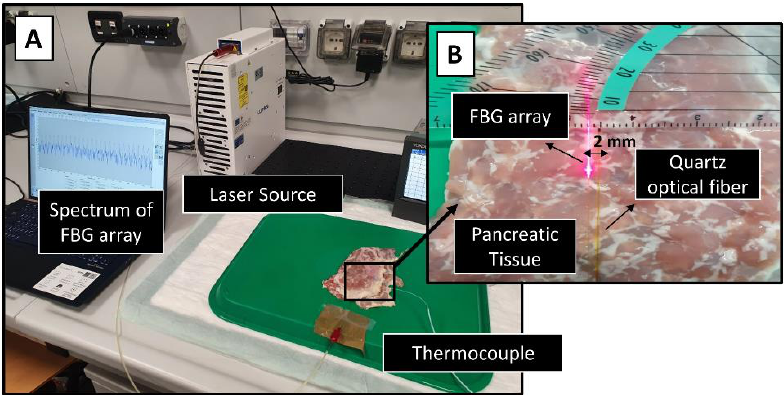
Figure 2. ( A ) Set up for the measurement of the temperature enhancement in ex vivo pancreas tissue during 120 s laser irradiation. ( B ) Magnification of the organ with the optical fiber placed in the middle part of that.